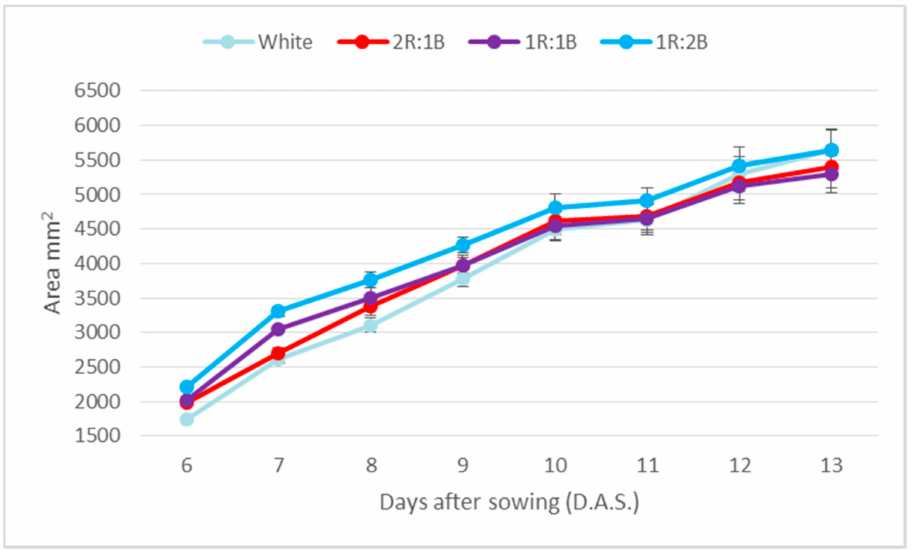
Figure 1. Total cotyledon area of green basil cultivar.